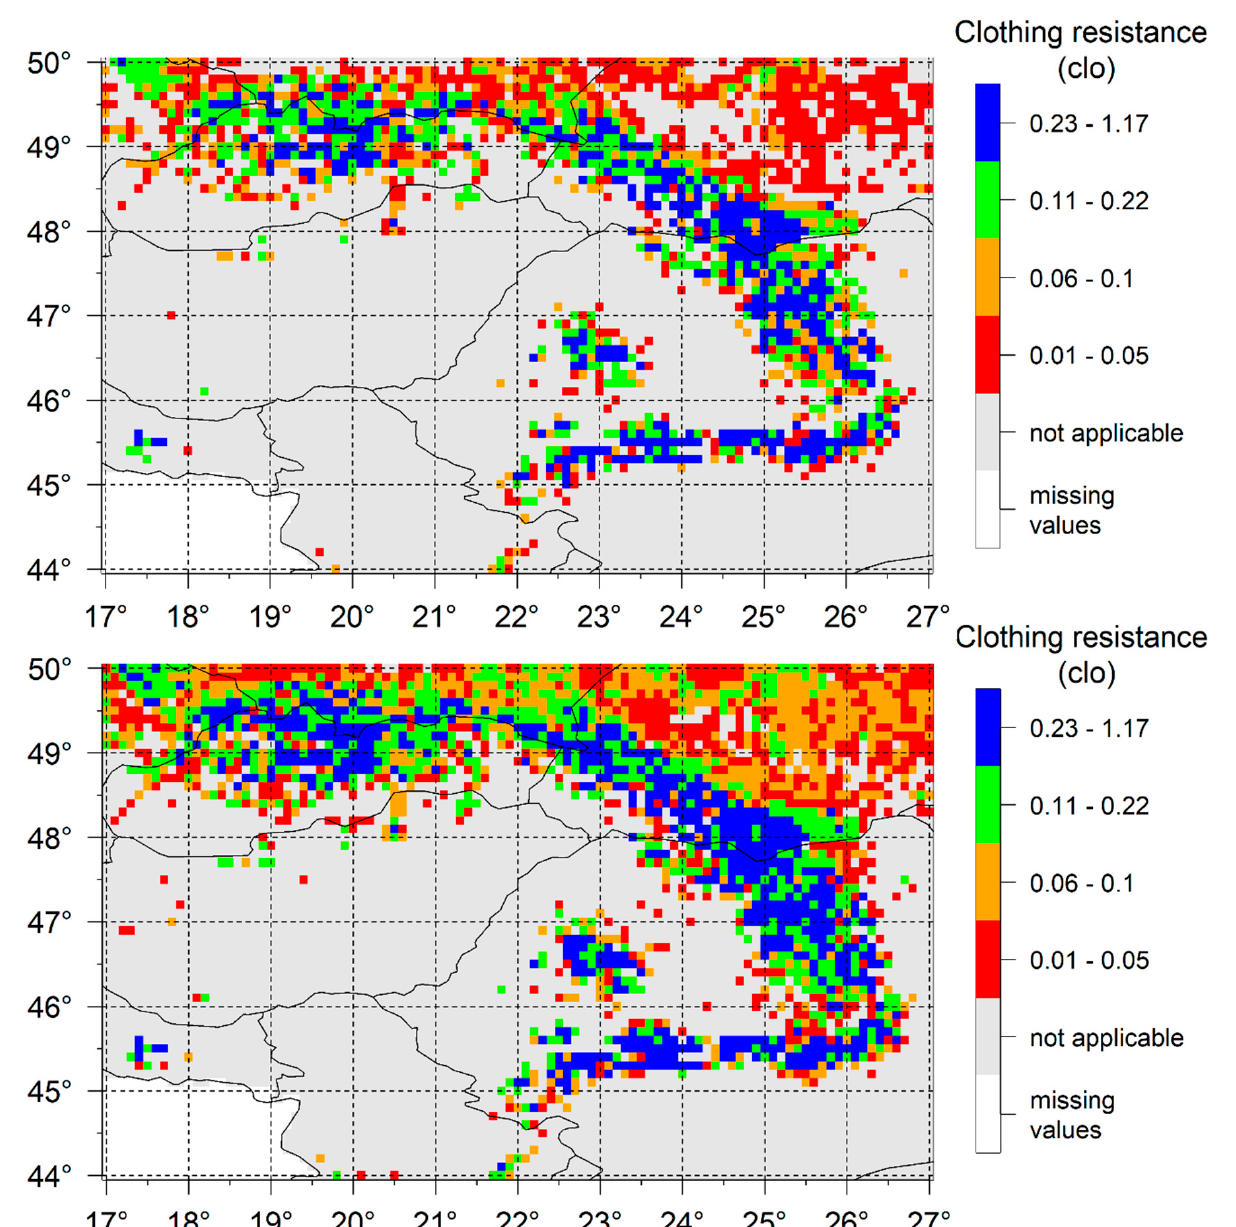
Figure 9. Spatial distributions of July clothing thermal resistance values obtained by using the new statistical deterministic scheme for persons 1 and 2 representing the average adult Hungarian male ( top ) and female ( bottom ) in the CarpatClim dataset region for the period 1971–2000.